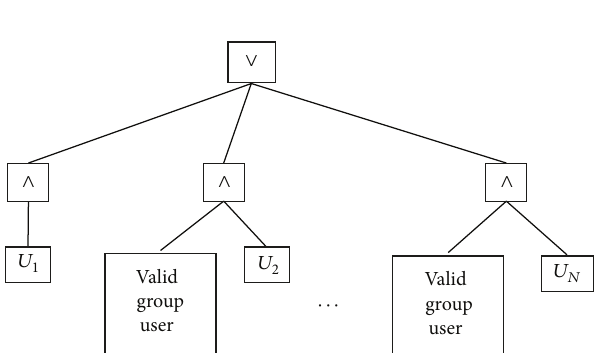
Figure 1: Initial access tree.